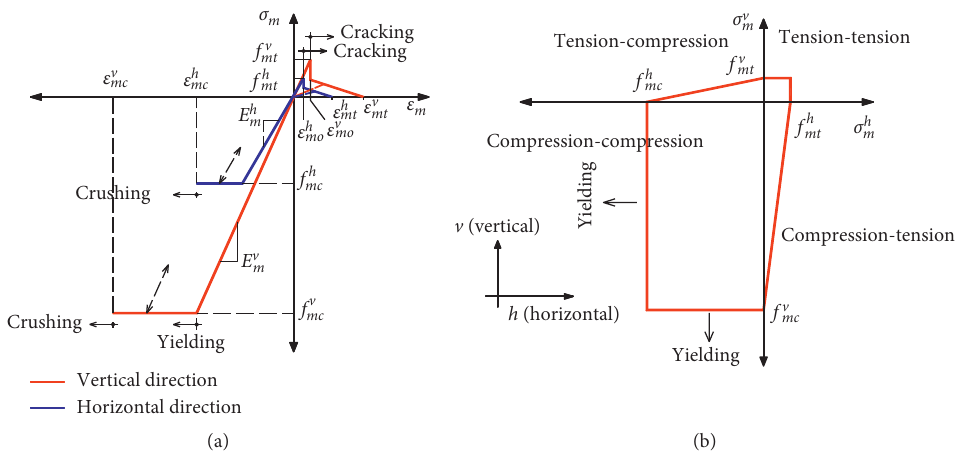
Figure 1: Adopted orthotropic masonry model under normal stresses: (a) 1D representation; (b) 2D representation.